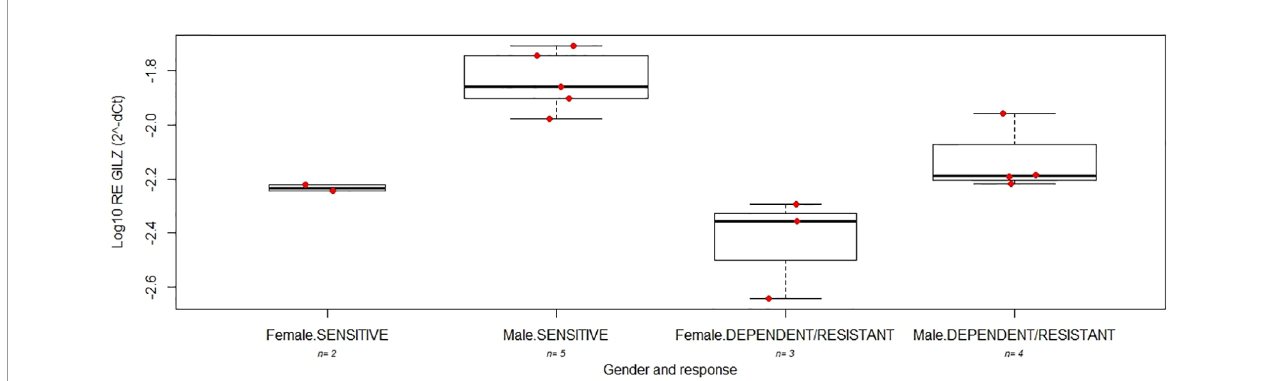
FIGURE 5 | The boxplots indicate the expression level of GILZ between good (SENSITIVE) and poor (DEPENDENT/RESISTANT) responders after 12 weeks of treatment with GC in female and male young patients